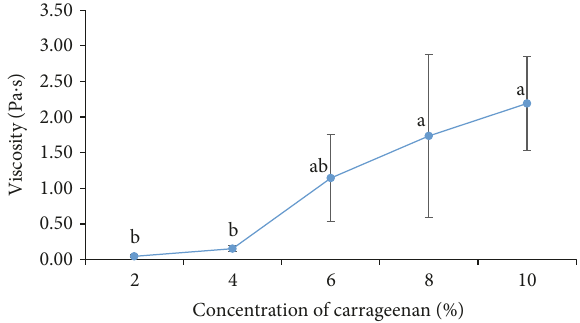
Figure 2: Pseudoplastic behavioural viscosity (Pa ⋅ s) of different carrageenan concentrations (%, w/v). The experiments were carried out in triplicate ( 𝑛 = 3 ). Different alphabet shows significant difference ( 𝑝 < 0.05 ) between samples.